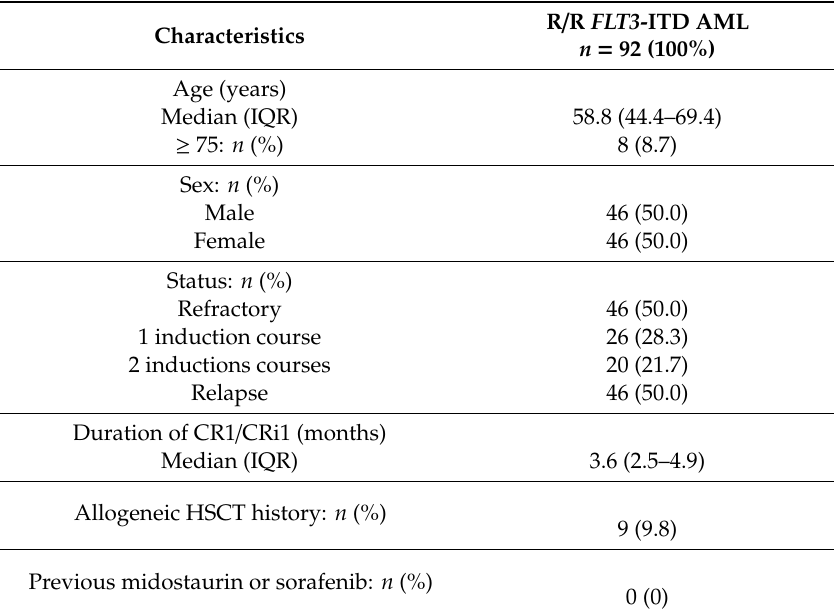
Table 4. Characteristics of patients with R / R < 6 months FLT3 -ITD AML ( n = 92).